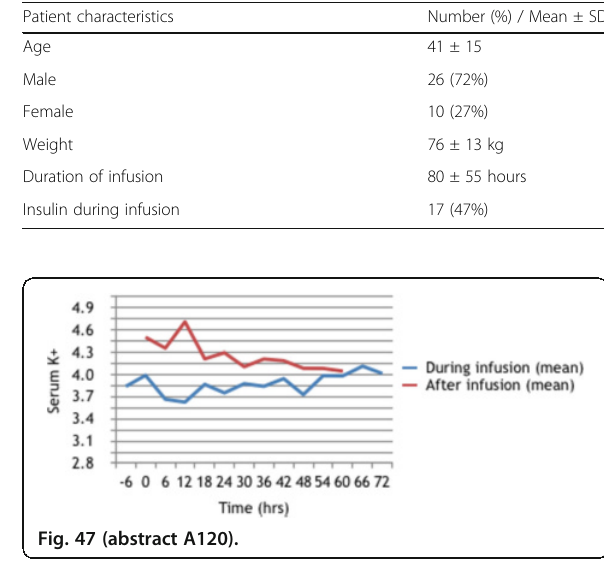
Table 44 (abstract A120).